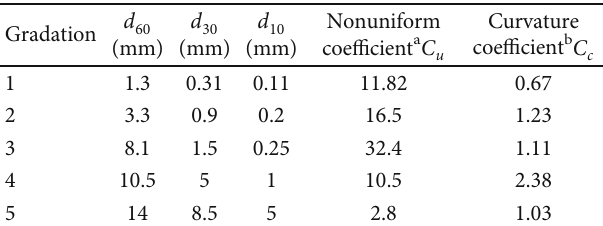
Table 4: Gradation